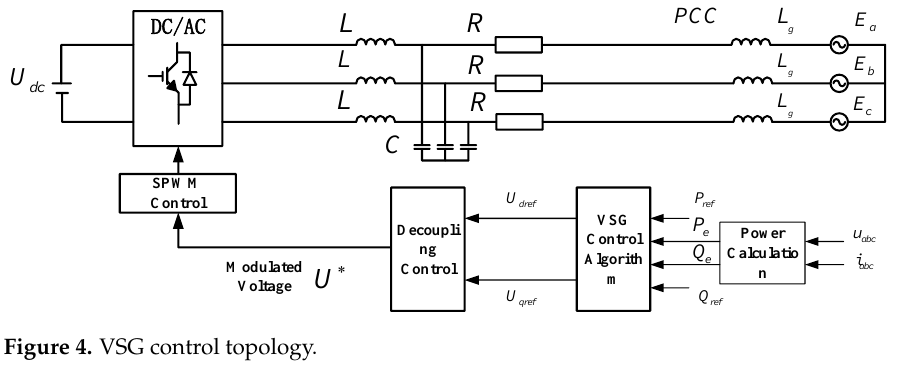
Figure 4. VSG control topology.